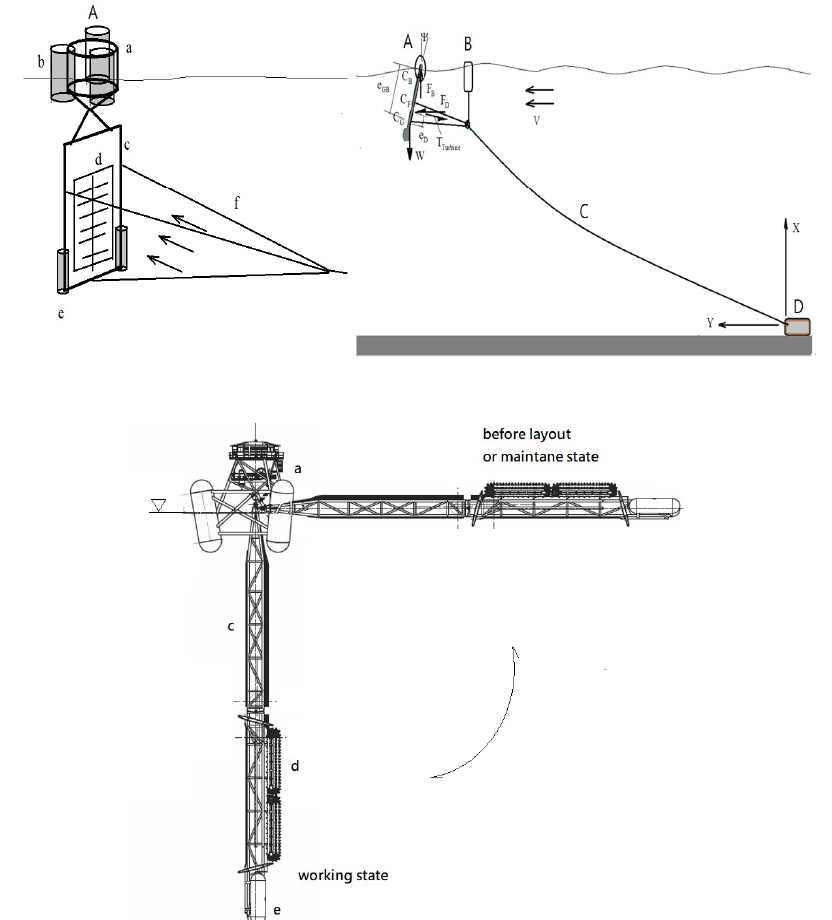
Figure 1. Current turbine system composed of turbine ( A ) (a: Generator; b: Float; c: Structure; d: Translational blade; e: Balanced weight; f: Cable; the current energy transferred by the blade to generator through the high-pressure oil); buoyance platform ( B ); traction rope (UHMWPE) ( C ); and anchor ( D ).